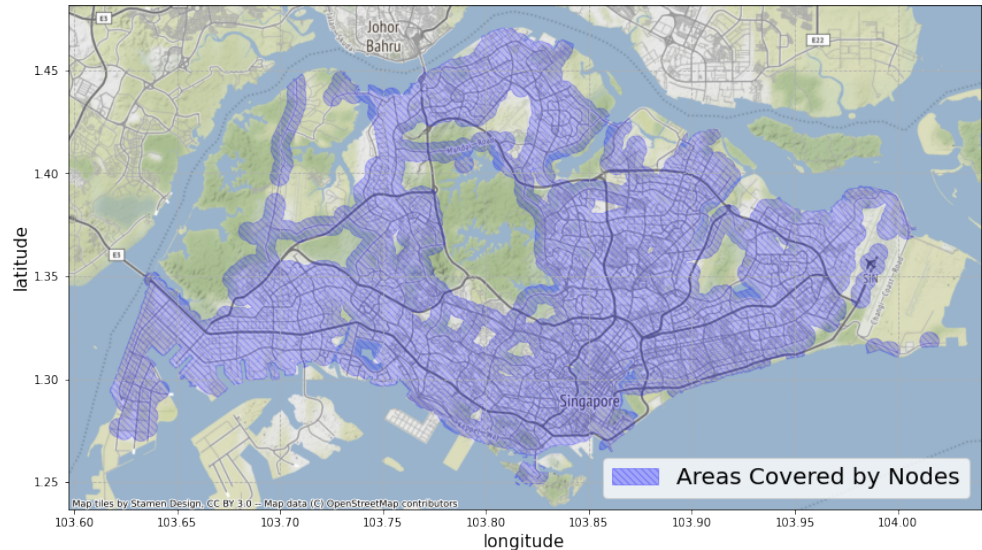
Figure 5. The areas covered by all of the nodes defined according to Section 4.1.1. As shown in the figure, the nodes covered most urban areas in Singapore. The areas not included are either natural reserves (the green areas) or industrial areas (the bottom island and the areas on the